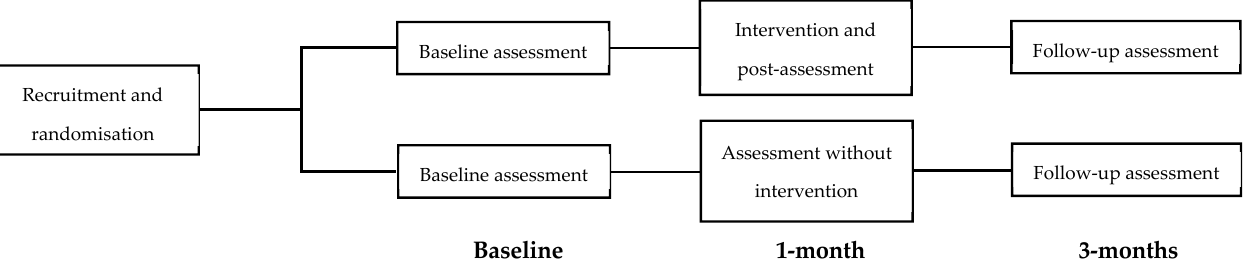
Figure 2. Flow diagram of both evaluation designs.